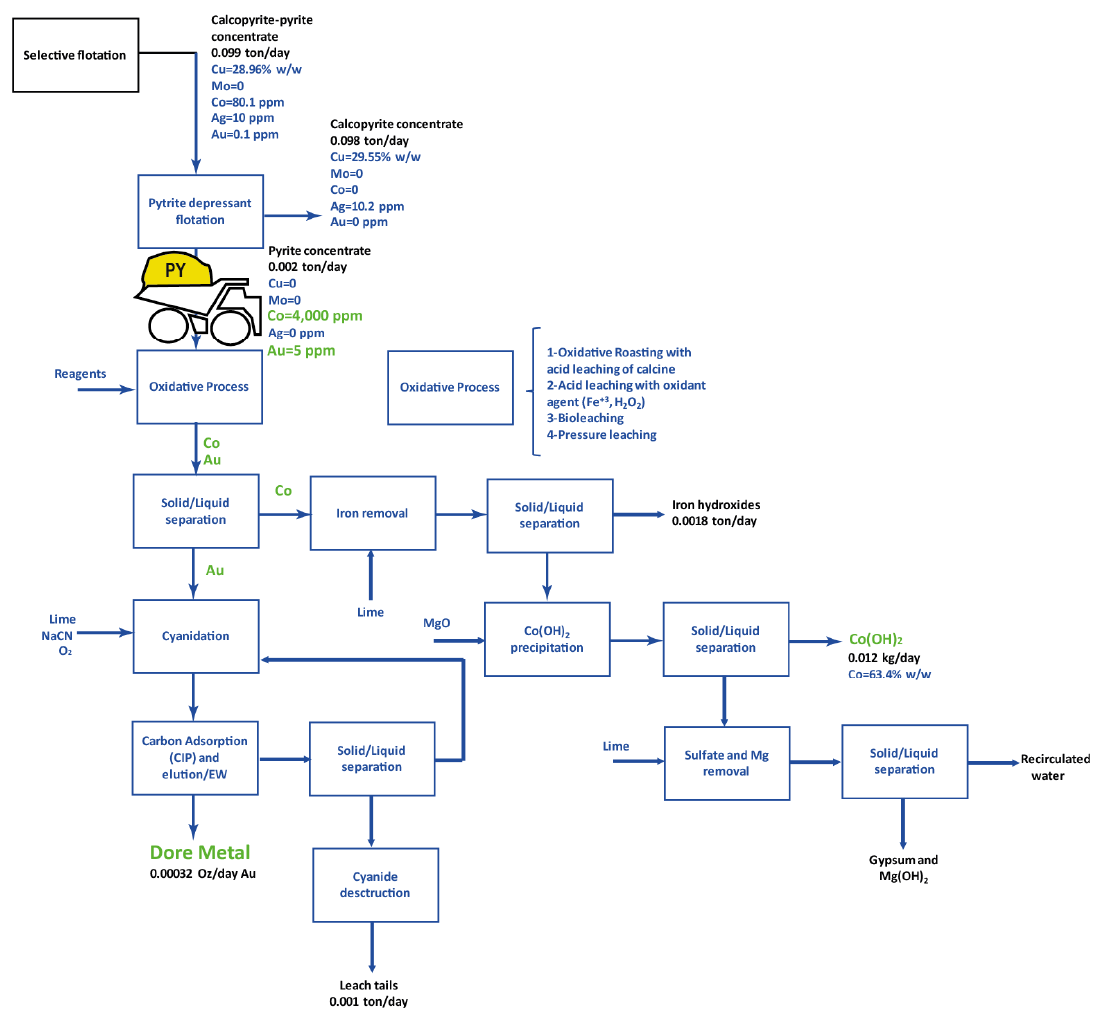
Figure 10. Schematic flow-sheet proposed to recover marketable critical metals, such as Co and Au from a pyrite concentrate, during sulfide concentrate production.